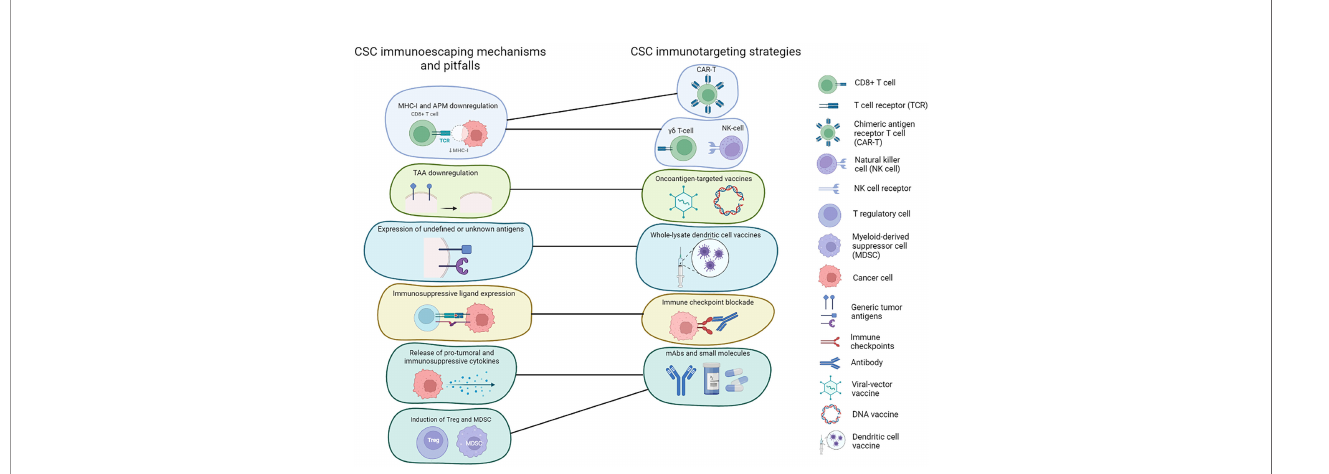
FIGURE 1 | Immunotherapies targeting CSCs and CSC immunoescaping mechanism. Schematic representation of the main immunoevasive mechanisms adopted by BCSCs and how these can be addressed using different immunotherapeutic